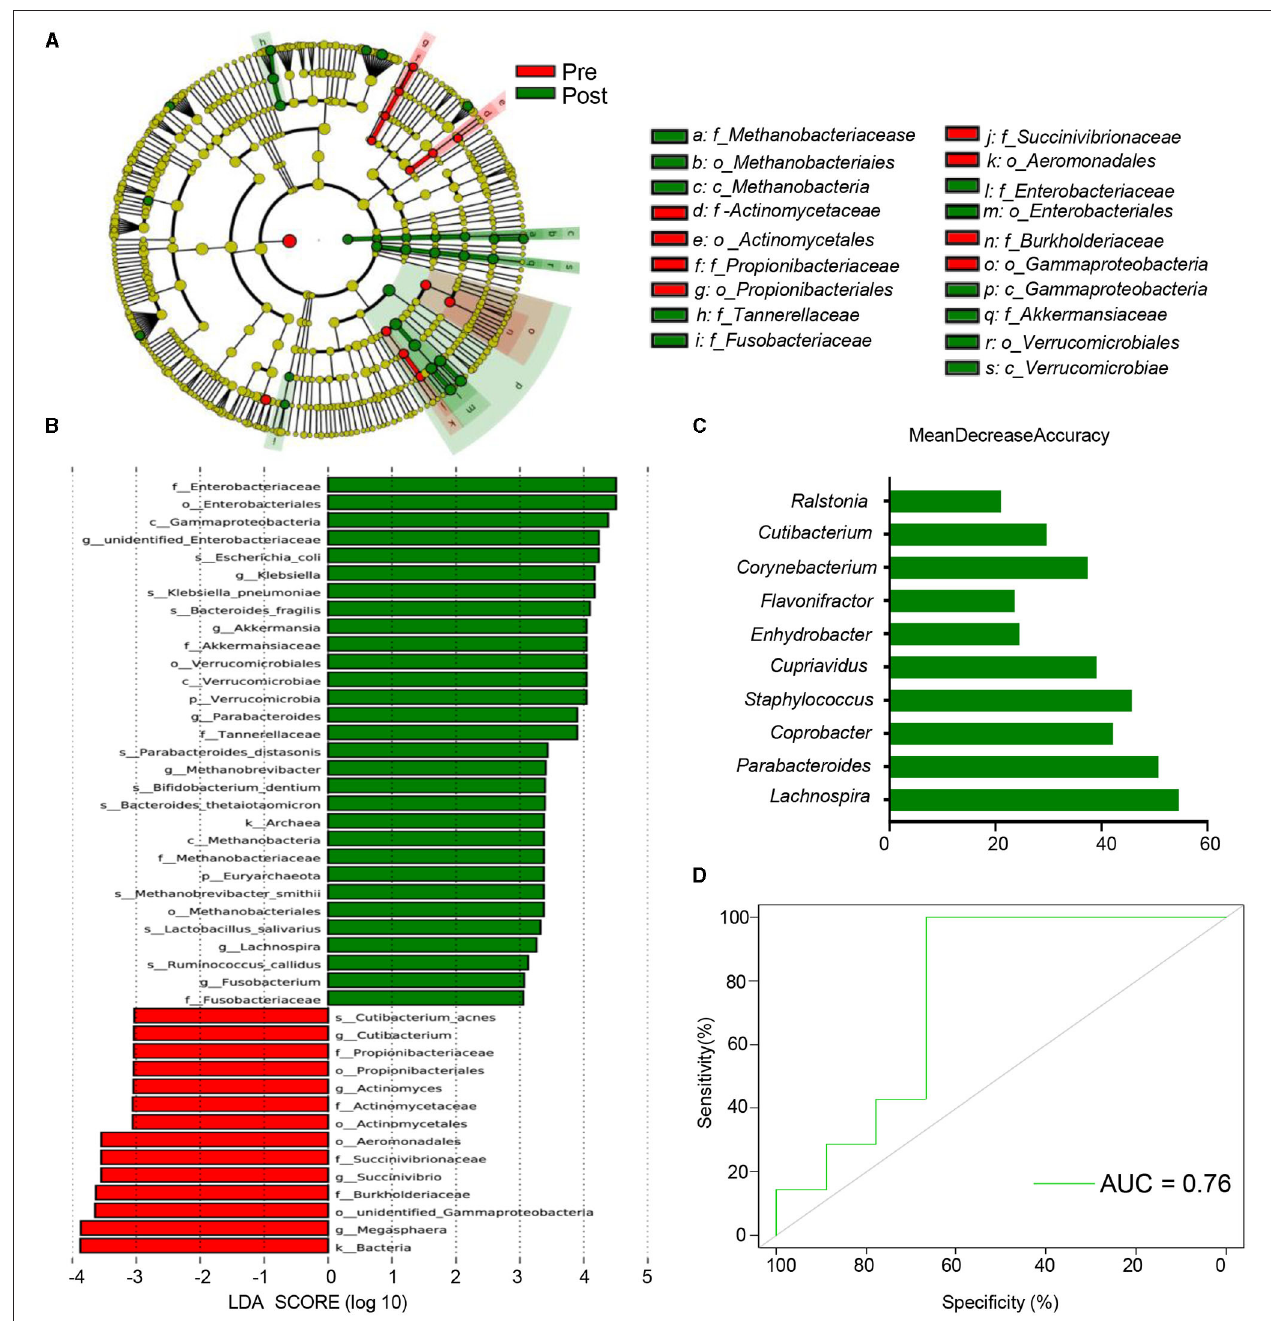
FIGURE 4 | Multiple possible targets for EA of antipsychotic-related constipation. (A) Cladograms generated by LEfSe indicating differences in the bacterial taxa between pre and post. Red bars indicate taxa were enrichment in Pre, green bars indicate taxa were enrichment in post. The p_, c_, o_, f_, g_, s_ represent phylum, class, order, family, genus, and species, respectively; (B) LDA scores for the bacterial taxa differentially abundant between pre and post (LDA > 3). Green bars indicate taxa were enrichment in post, and red bars indicate taxa were enrichment in pre; (C) the 10 most discriminant genera in the models classifying pre and post, which identified by machine learning using the random forest analysis. The bar lengths indicate the importance of the variable. The colors represent enrichment in pre (red) or post (green); (D) ROC curve displaying the classification for pre and post-employing 16S rRNA data. AUC, area under curve.